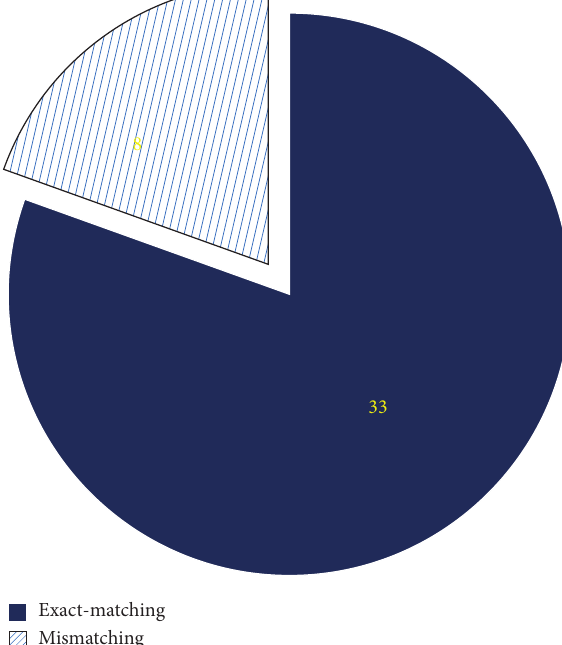
Figure 11: Verification results.